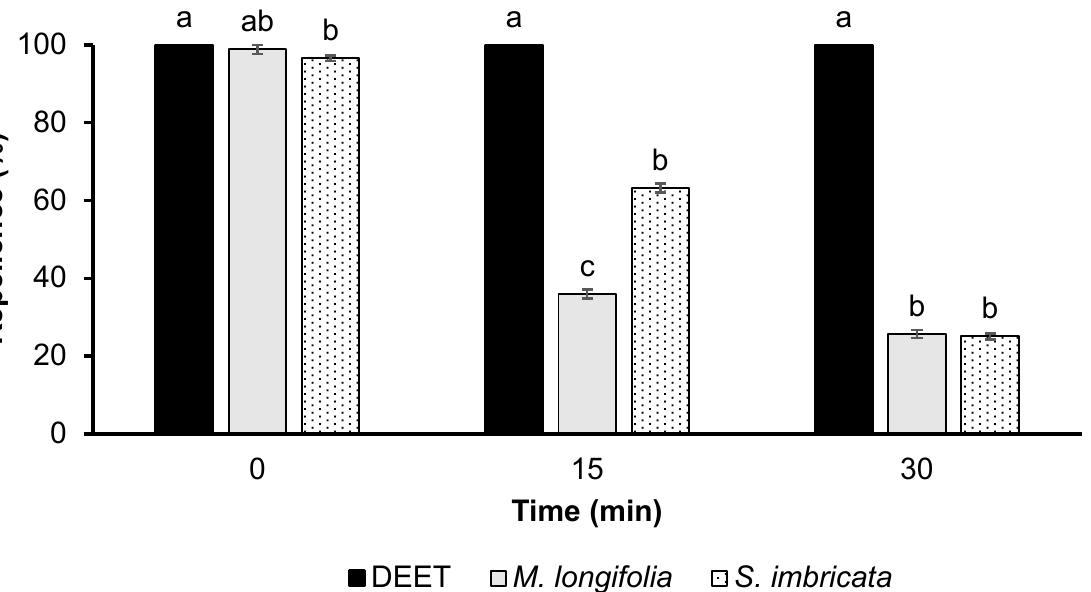
Figure 2. Time-based repellency of DEET and two essential oils tested at a dose of 33.3 µ g/cm 2 against Ae. aegypti . Bars having different letters depict significant differences ( p < 0.05) among the repellency of different tested substances at 0, 15, and 30 min of post-treatment when compared independently by ANOVA post hoc Tukey test. Error bars denote the standard error (n = 5).